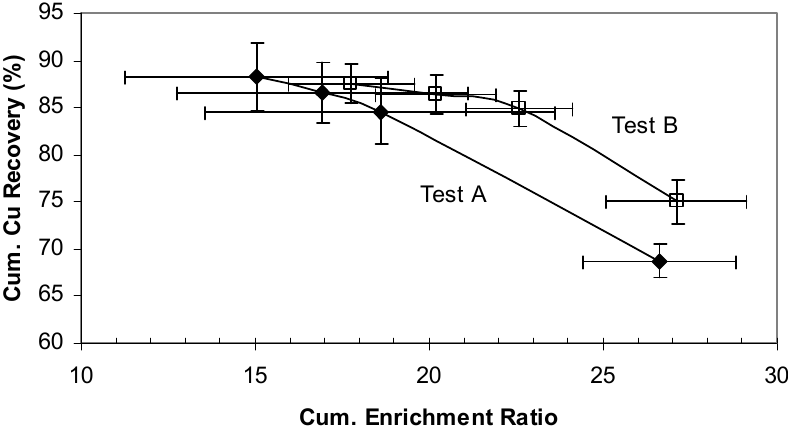
Figure 1. Ninety percent confidence intervals on two batch flotation grade-recovery curve points (from [4] with